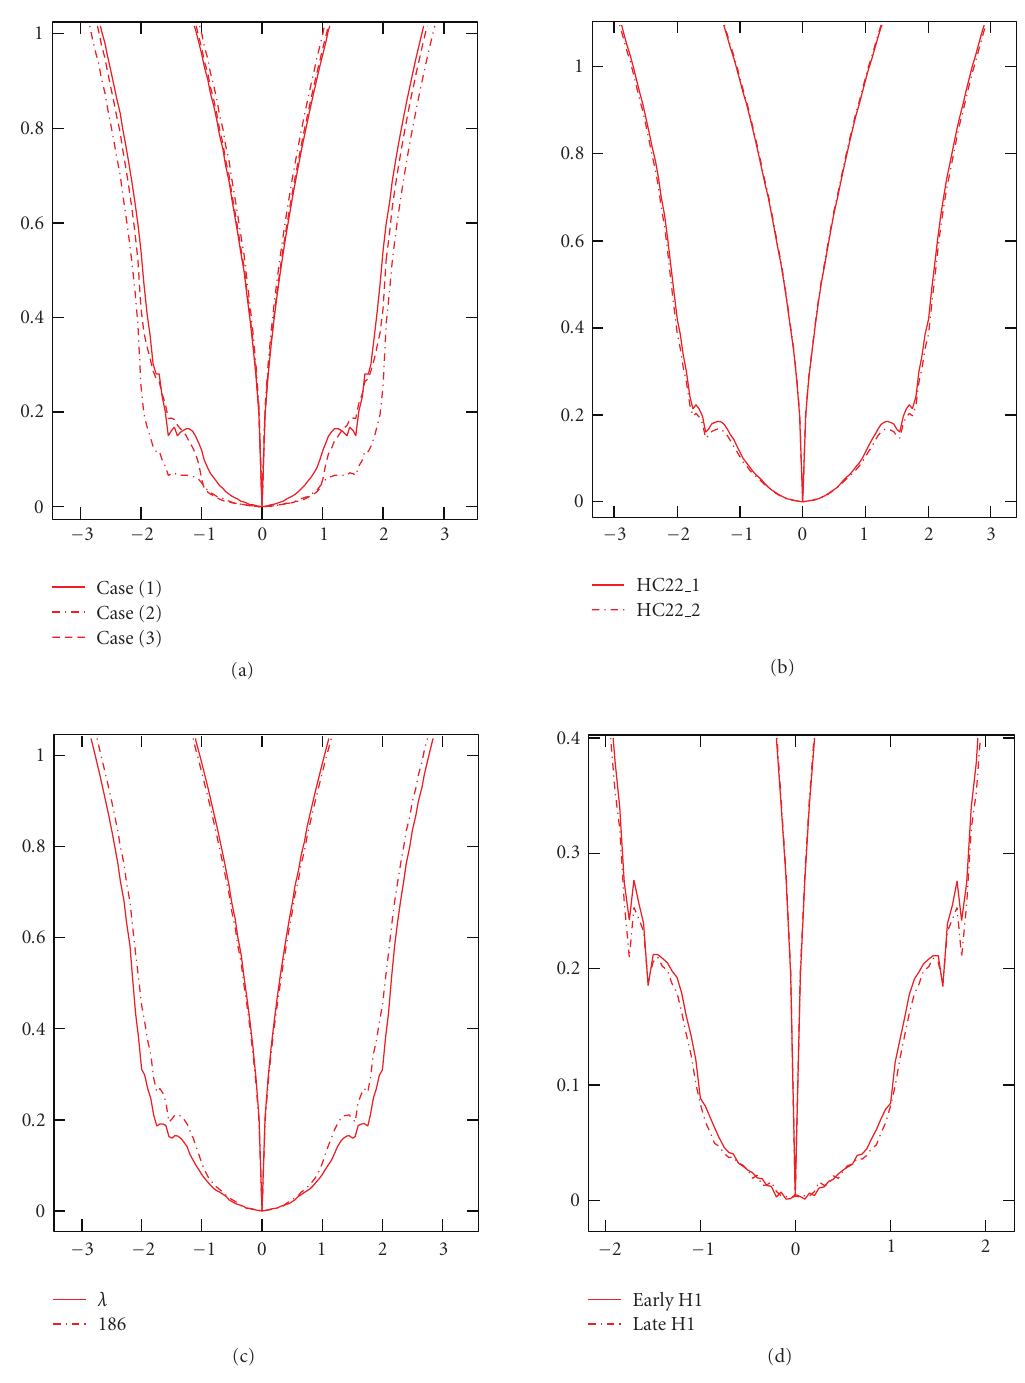
Figure 13: Lyapunov exponents ( γ 1 , γ 2 ) as a function of energy in the ladder model. (a) Modified Bernoulli model, where case (1): B 0 = 1 . 0, B 1 = 1 . 0, Case (2): B 0 = 1 . 0, B 1 = 1 . 9, and Case (3): B 0 = 1 . 7, B 1 = 1 . 9 are shown. (b) HC-22. (c) Bacteriophages of E. coli (phage- λ , phage-186). (d) Early histone H1 and late histone H1. The on-site energy is set at A nn = B nn = 0, a = − 1 . 0, and b = − 0 . 5. The size of the sequence is N = 10 5 for (a), N = 10 5 for (b), N = 48510 for the phage- λ in (c), N = 30624 for the phage-186 in (c), N = 787 for the early histone H1 in (d), and N = 1182 for the late histone H1 in (d).